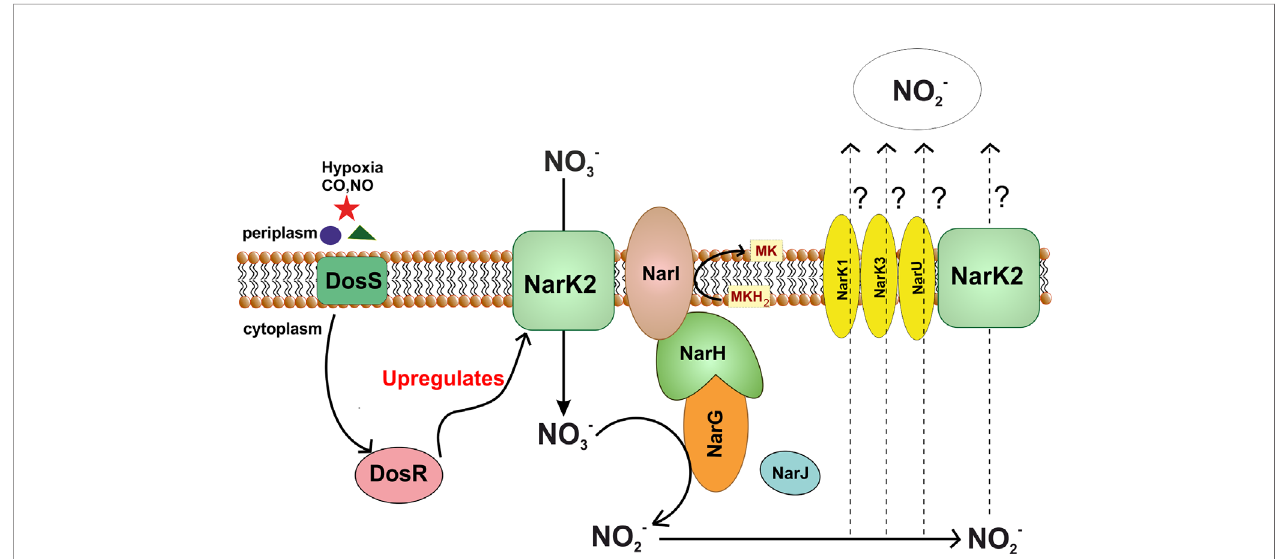
FIGURE 6 | Nitrate reductase pathway in M. tuberculosis . Figure shows dependence of nitrate reductase pathway upon DosS-DosR two component system of Mtb. In stress conditions such as hypoxia, DosR upregulates expression of NarK2, which in turn, transports nitrate into the cytoplasm. This nitrate is reduced to nitrite with the help of NarGHI. In this process, electron from menaquinol are used for reduction of nitrate. Nitrate produced in the process is transported out, however the nitrate transporter remains to be identi fi